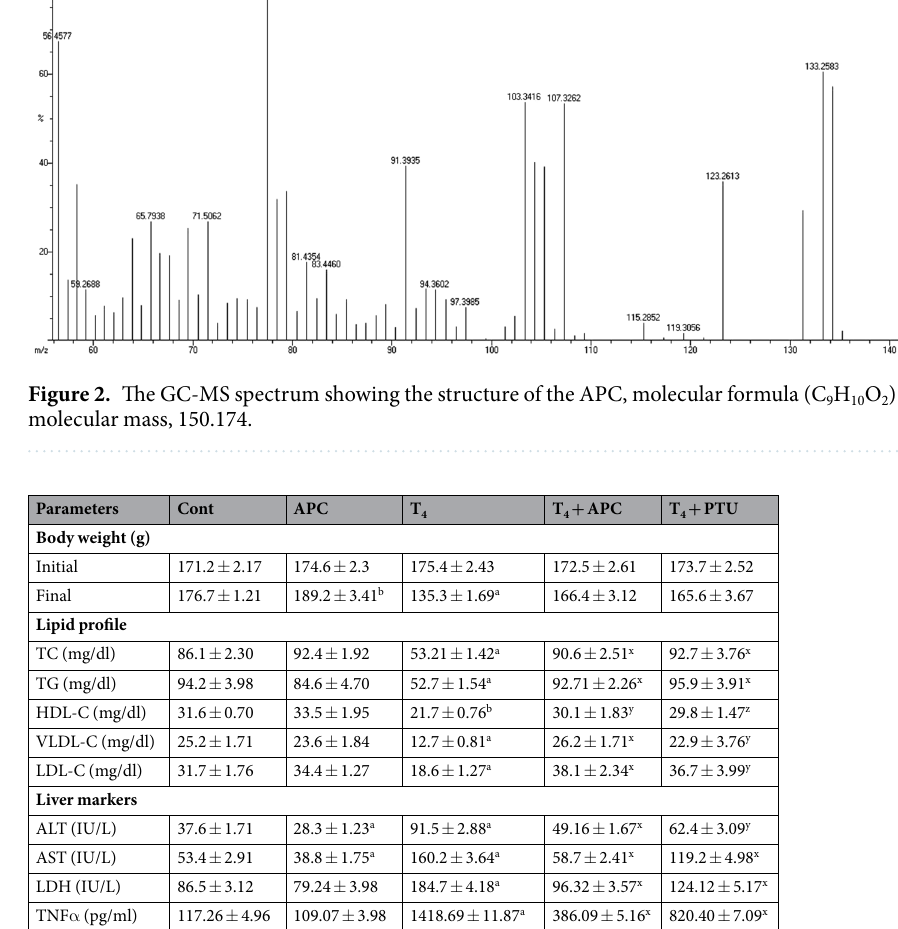
Table 1. Effects of the test compound, APC on body weight, different serum lipids & liver marker enzymes in the normal and T 4 -induced rats. Data are in means ± SEM, n = 7. a P < 0.001 and b P < 0.01 as compared to their initial b.wt. a P < 0.001 and b P < 0.01, as compared to the respective control value; whereas x P < 0.001, y P < 0.01 and z P < 0.05 as compared to the respective value of thyroxin (T 4 ) treated